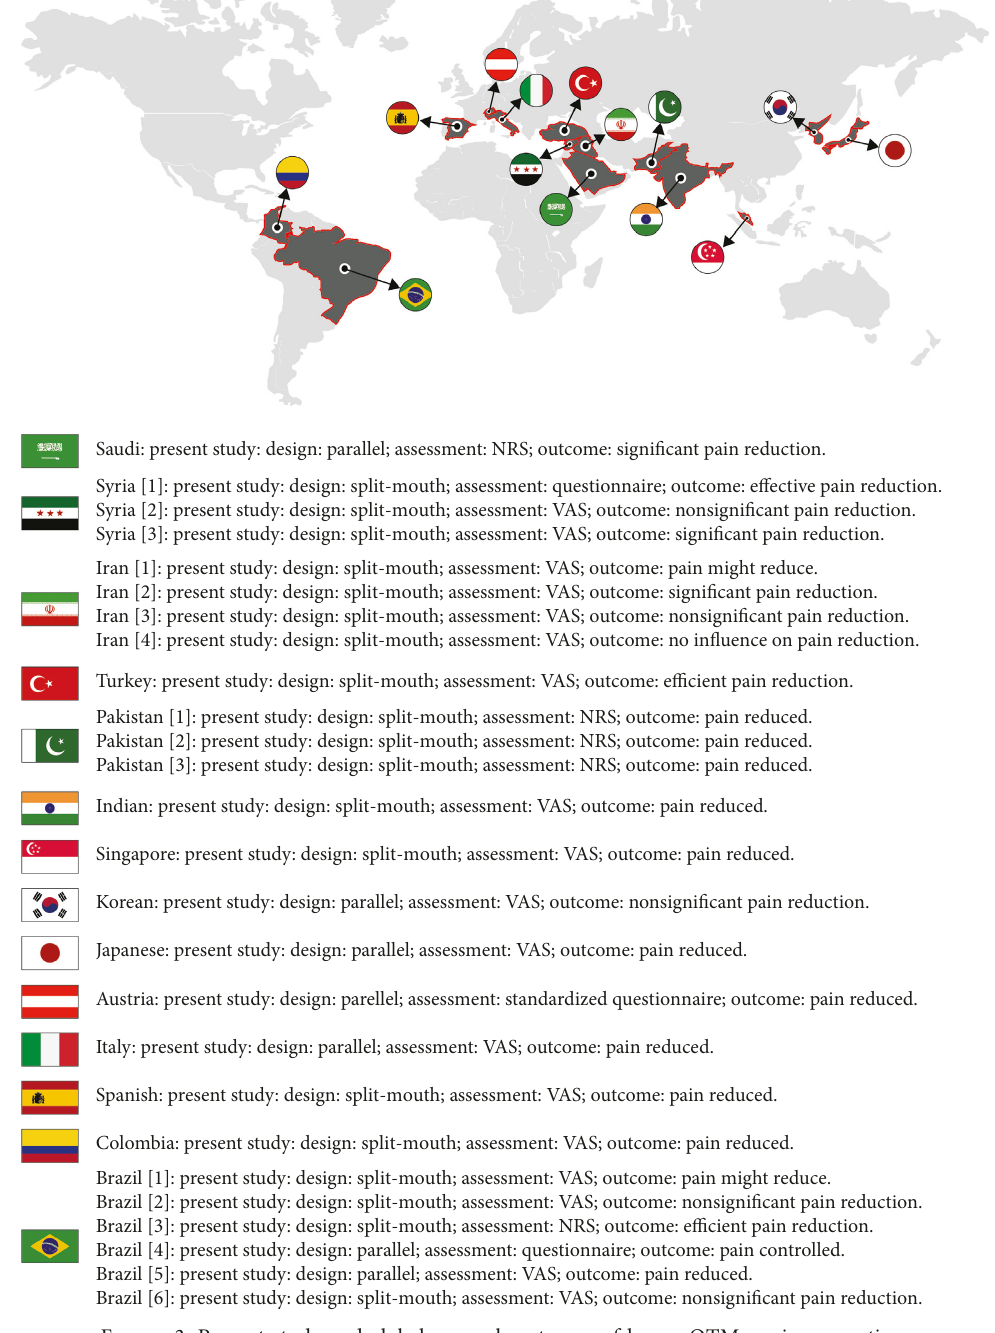
Figure 3: Present study and global research outcome of laser +OTM+pain